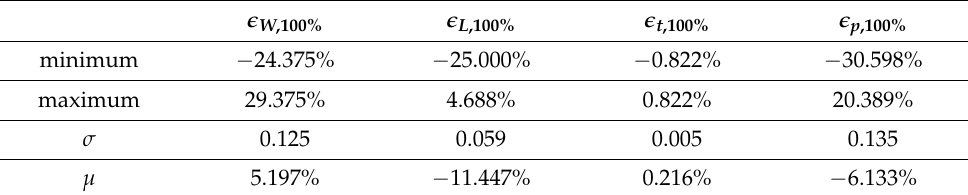
Table 6. Bounds calculated from MVA error measurements.